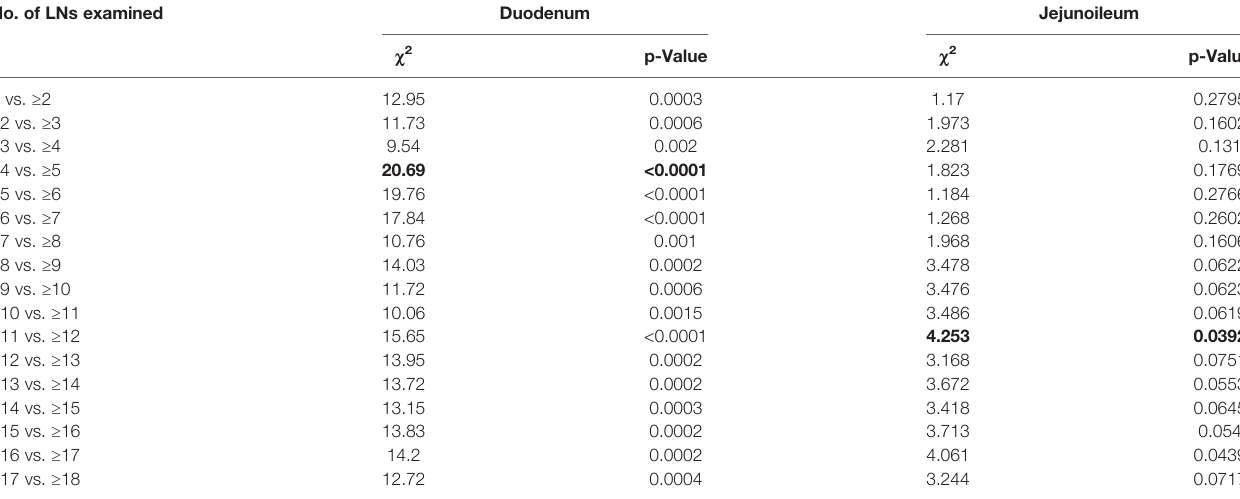
TABLE 2 | Cut-point analyses for detecting optimal number of lymph nodes with respect to cancer-speci fi c survival. No. of LNs examined Duodenum Jejunoileum c 2 p-Value c 2 p-Value 1 vs. ≥ 2